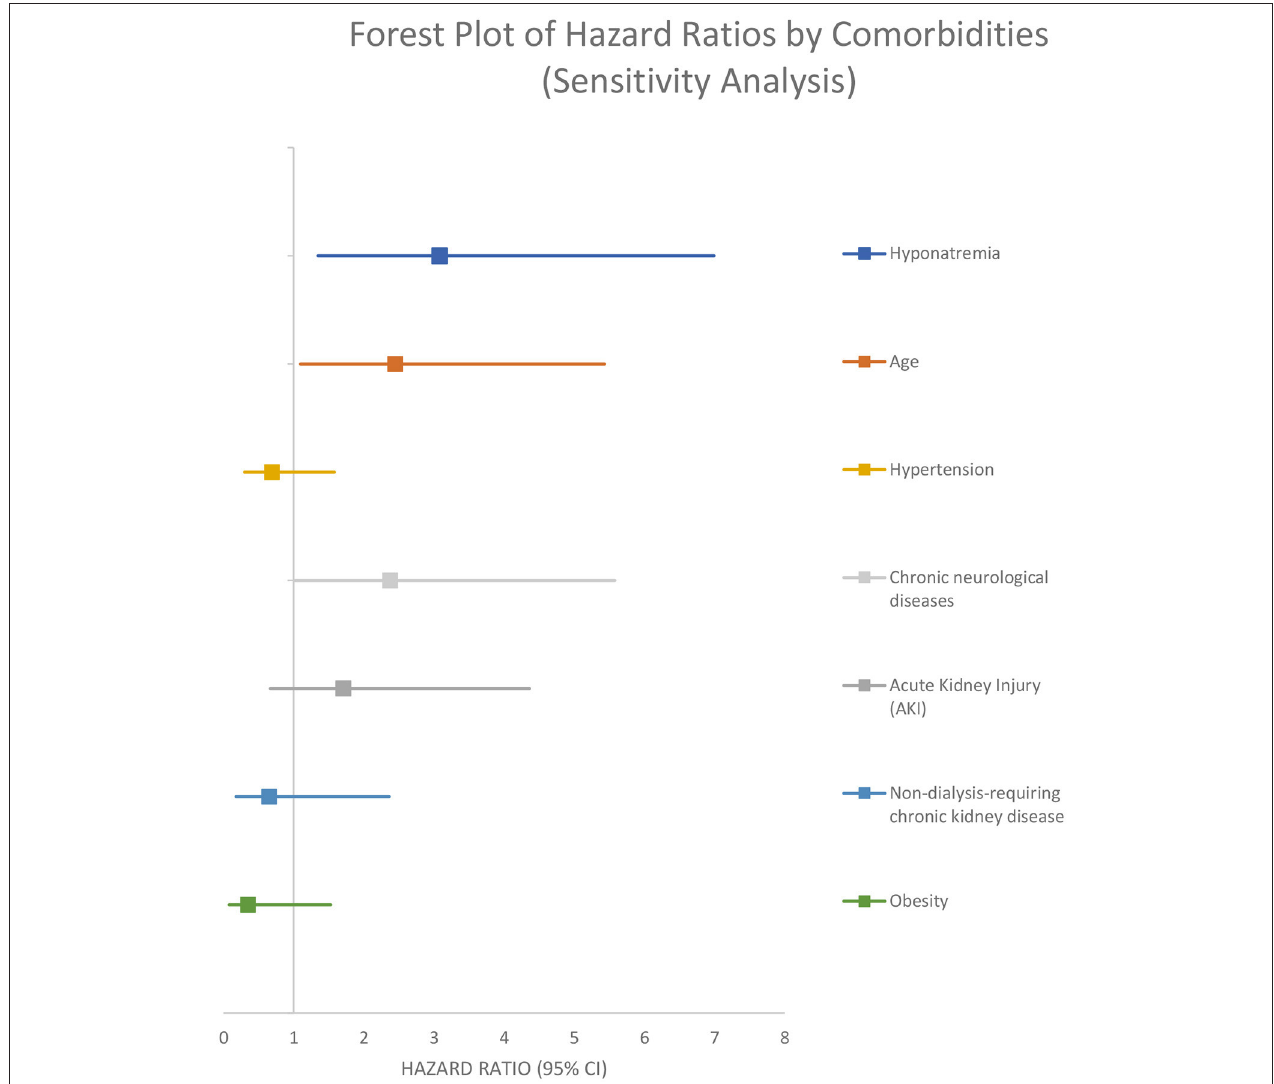
FIGURE 6 | Sensitivity